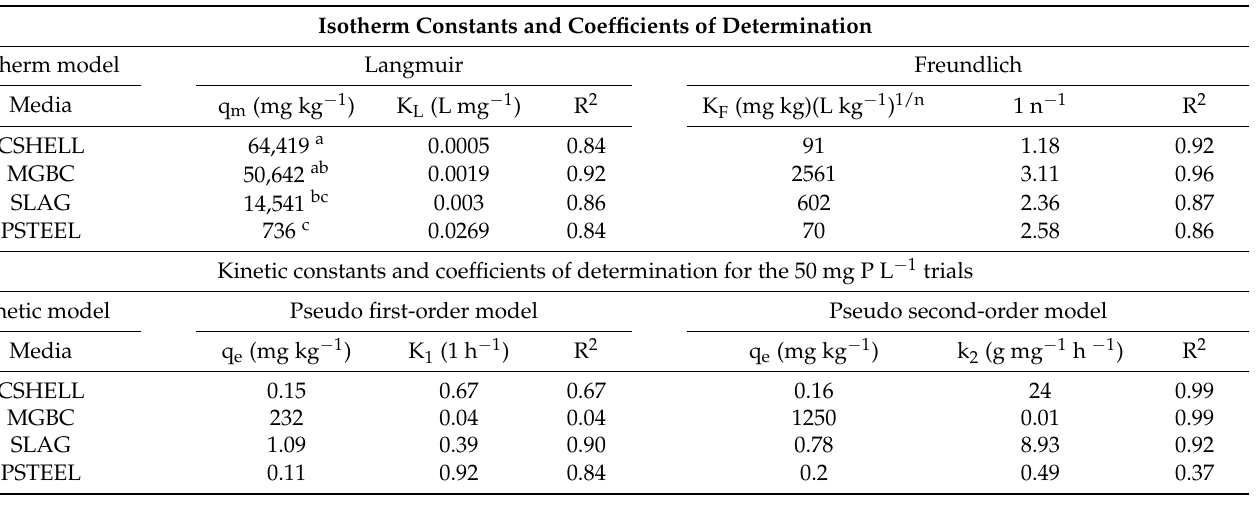
Table 2. Adsorption isotherm and kinetic characteristics of reactive media. Treatments with similar letters (a and b) did not show statistical significance at the α = 0.05 level.